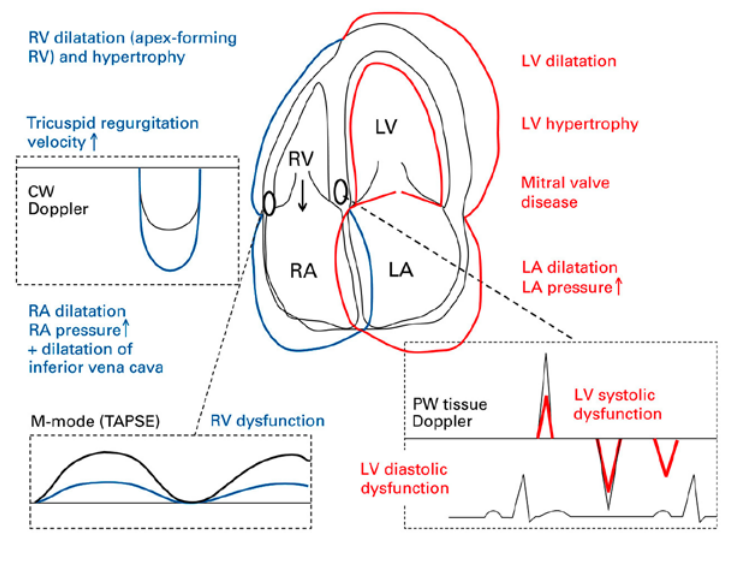
Approach to the patient with suspected pulmonary hypertension (modified and simplified according to [3]). *There is no accepted definition of the severity of pulmonary hypertension. As an arbitrary definition it is suggested that “moderate/severe pulmonary hyperten- sion” is a peak tricuspid regurgitation velocity (TRV) 2.9–3.4 m/s + indirect signs of pulmonary hypertension OR peak TRV >3.4 m/s with/without indirect signs of pulmonary hypertension. Ac- cordingly, “mild pulmonary hyperten- sion” is peak TRV ≤ 2.8 m/s but indirect signs OR peak TRV 2.9–3.4 m/s without indirect signs. For further details, please see text. CPET = cardiopulmonary exercise test; LHD = left-sided heart disease; LVEDP = left ventricular end-diastolic pressure; PAH = pulmonary arterial hypertension; PH = pulmonary